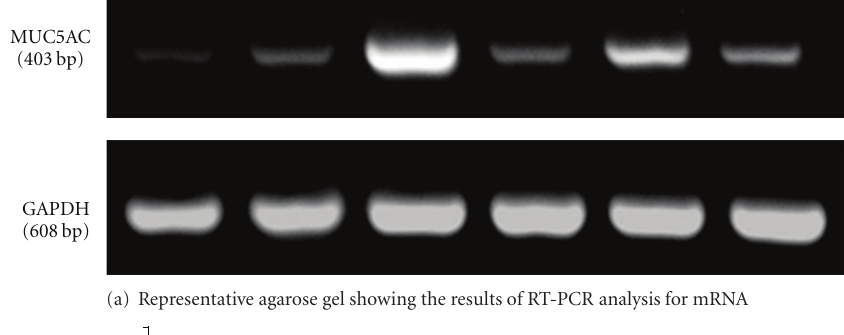
(a) Representative agarose gel showing the results of RT-PCR analysis for mRNA